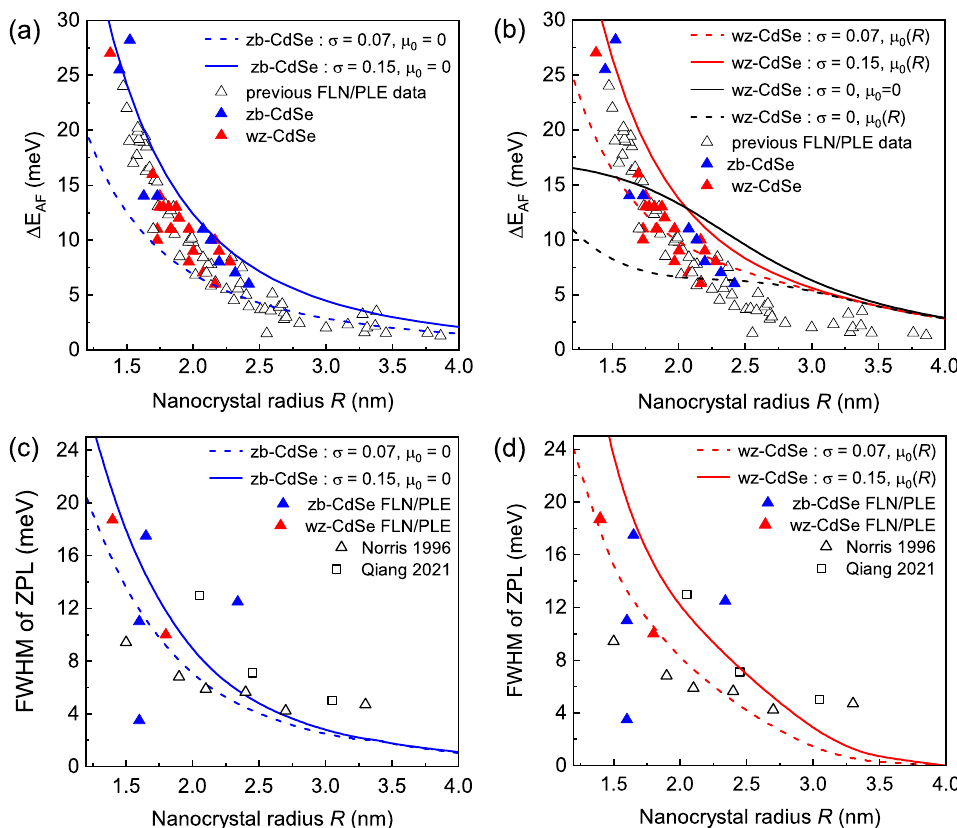
Figure 6. ( a ) Calculated energy of the ZPL maximum in an ensemble of zb-CdSe NCs for σ varying from 0.07 to 0.15. Symbols show the experimental FLN/PLE data from Figure 3b. Here, colored triangles show the joint set of data obtained using excitation by the Hg lamp and the Ar ion laser. ( b ) Calculated energy of the ZPL maximum in an ensemble of wz-CdSe NCs with σ varying from 0.07 (red dashed line) to 0.15 (red solid line) and with the size-dependent µ 0 ( R ) from Ref. [16]. Solid and dashed black lines show calculated ∆ E AF with σ = 0 and µ 0 = 0 or µ 0 ( R ) from Ref. [16], respectively. ( c ) Calculated dependence of the ZPL linewidth on the NC radius for σ varying from 0.07 (dashed lines) to 0.15 (solid lines) in zb-CdSe NCs with µ 0 = 0. Symbols show experimental values from the current and previous studies [23,27]. ( d ) Calculated dependence of the ZPL linewidth on the NC radius for σ varying from 0.07 (dashed lines) to 0.15 (solid lines) in wz-CdSe NCs with µ 0 ( R ) taken from Ref.